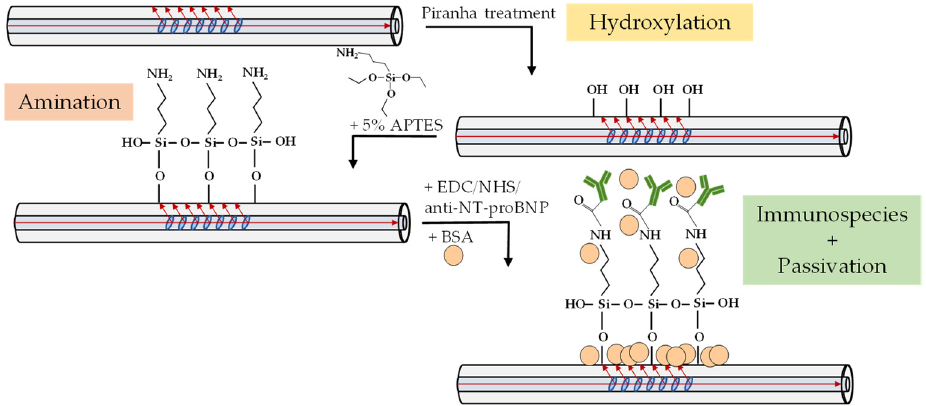
Figure 1. Sketch of the biofunctionalization steps for the bare TFBG.